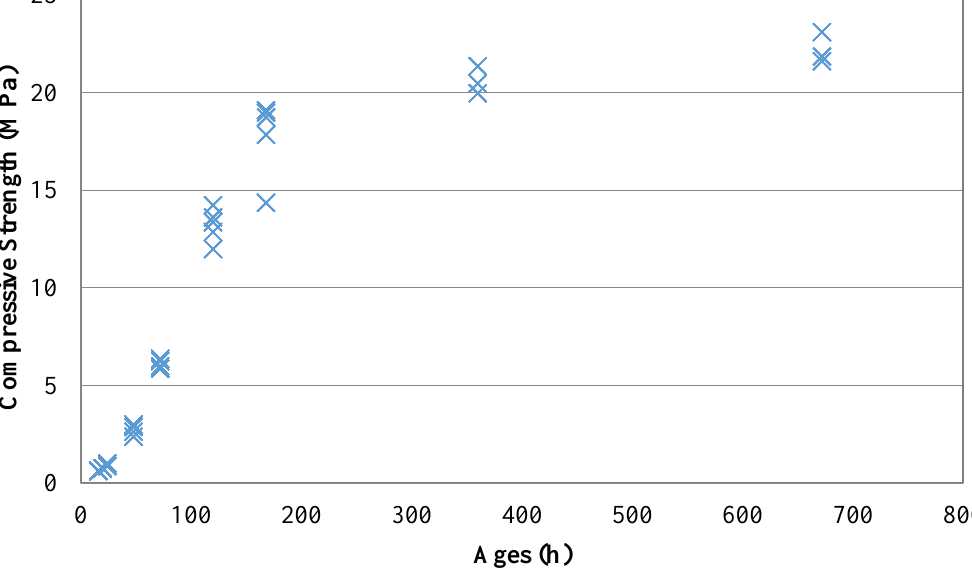
Figure 5. Compressive strength with age (24 MPa).